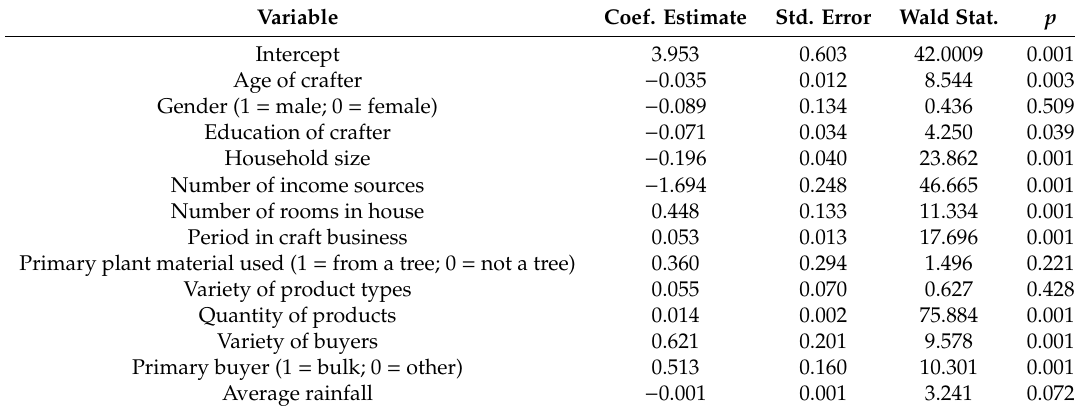
Table 5. Determinants of craft income in Eswatini, Malawi and Zimbabwe, 2016.